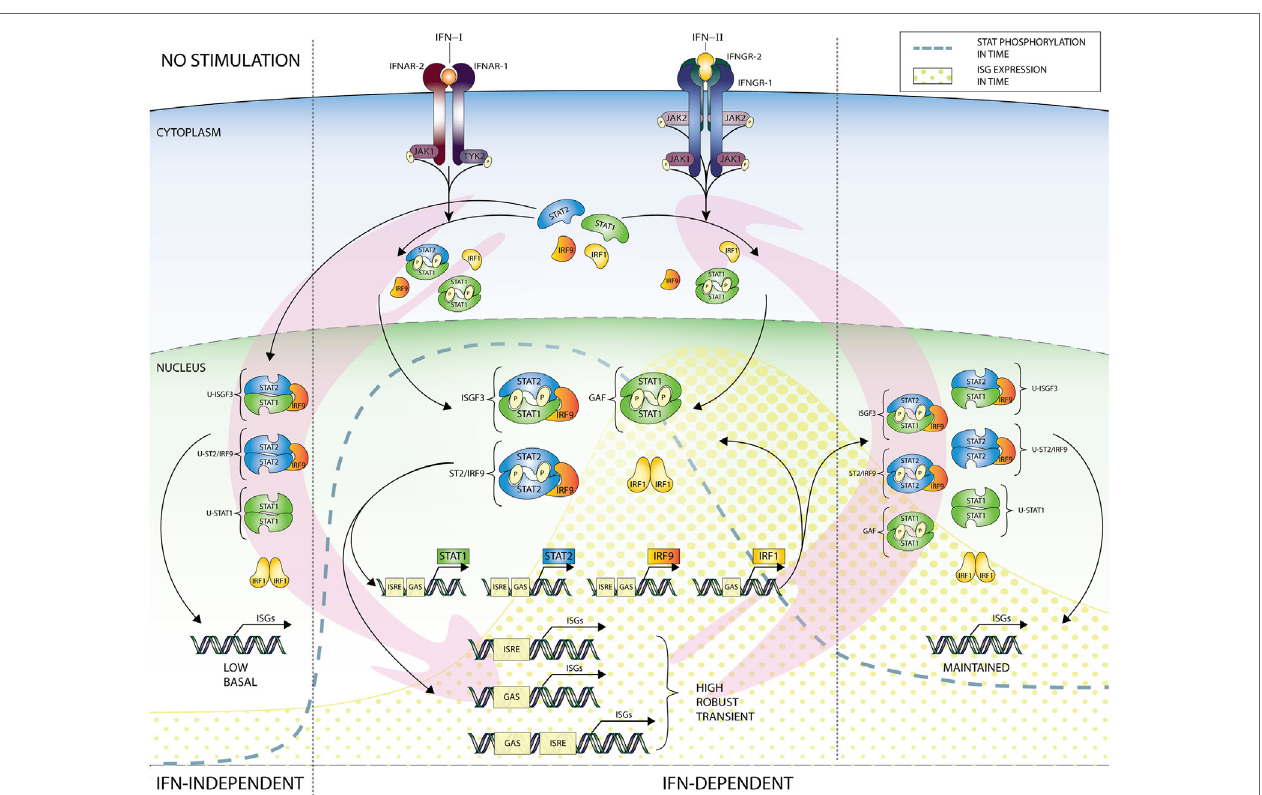
FiGUre 5 | Cooperation of unphosphorylated and phosphorylated ISGF3 and GAF components and IRF1 in the regulation of basal and IFN-induced transcription. In unstimulated cells, most of the known ISGs are expressed at low but detectable levels. Among these genes, there are examples of components (STATs and IRFs) of transcription factors, which in the absence of stimulation can combine in unphosphorylated complexes (U-ISGF3, U-STAT1, U-STAT2/IRF9, and IRF1) and drive the constitutive expression of ISGs. After cell stimulation with IFN type I or II, receptors dimerize and enable receptor-bound kinases (JAK1 and TYK2 for IFN-I or JAK1 and JAK2 for IFN-II) transphosphorylation and STAT protein recruitment. Next step is phosphorylation of STATs, which can now dimerize and with or without a partner (IRF9) create complexes—ISGF3, ST2/IRF9, and GAF, then translocate to the nucleus and start a high and robust but transient expression (yellow dotted graph) of GAS and/or ISRE-containing ISGs. This leads to, inter alia , rapid accumulation of newly synthesized STAT1, STAT2, IRF9, and IRF1 proteins in the cytoplasm, which can create new transcription factors in unphosphorylated form (U-ISGF3, U-STAT1, and U-STAT2/IRF9), and while level of phospho-proteins is dropping (dotted line) support or take over the role of phosphorylated complexes in sustaining the expression of ISGs. Important role in the circuit plays IRF1, which can occupy ISRE-containing genes and co-binds with other factors to modulate IFN-induced response, as well as basal ISG expression. As shown in the graph, responses to both types of IFN rely on common elements and events of the JAK–STAT signaling pathway and result in partially shared outcome. Thus, IFN-I and IFN-II induce a common as well as a unique set of genes. These facts clearly point to functional and biological overlap between IFN-I and IFN-II action and additionally to existence of mechanisms allowing cells to manage and adjust both responses. Abbreviations: IFN, interferon; STAT, signal transducer and activator of transcription; IRF, interferon regulatory factor; JAK, Janus kinase; TYK, tyrosine kinase; ISGF3, interferon-stimulated gene factor 3; GAF, γ -activated factor; ISRE, interferon-stimulated response element; GAS, γ -activated sequence; ISG, interferon-stimulated gene; P, phosphate; U, unphosphorylated